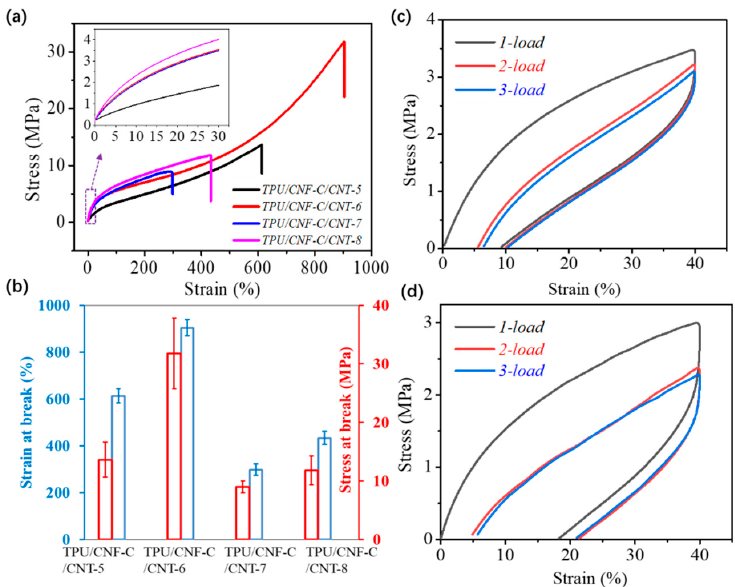
Figure 4. Measured mechanical properties of nanocomposite films, ( a ) typical tensile stress–strain Figure4. Measuredmechanicalpropertiesofnanocompositefilms, ( a )typicaltensilestress–straincurves, curves, the inset shows the stress–strain curve of each sample stretching up to 30%; ( b ) the strain and theinsetshowsthestress–straincurveofeachsamplestretchingupto30%; ( b )thestrainandstressvalues stress values at break for TPU/CNF-C/CNTs-5, TPU/CNF-C/CNTs-6, TPU/CNF-C/CNTs-7, at break for TPU / CNF-C / CNTs-5, TPU / CNF-C / CNTs-6, TPU / CNF-C / CNTs-7, TPU / CNF-C / CNTs-8; ( c ) experimental cyclic tensile of TPU / CNF-C / CNTs-6 film without using any stimulus; ( d ) cyclic tensile of TPU / CNF-C / CNTs-6 film under water